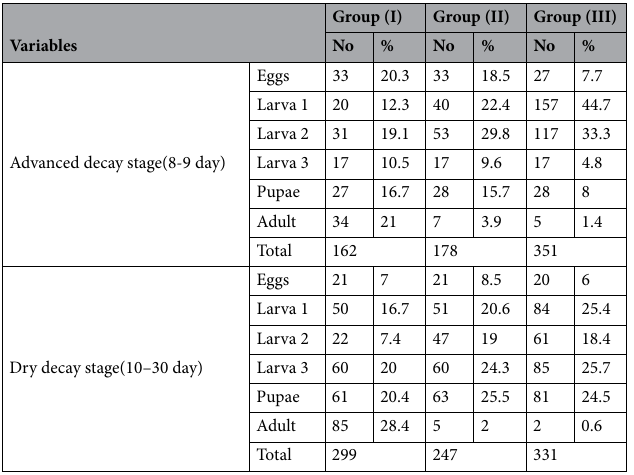
Table 2. Comparison between the studied groups in Arthropods of Forensic during 8–30 days.